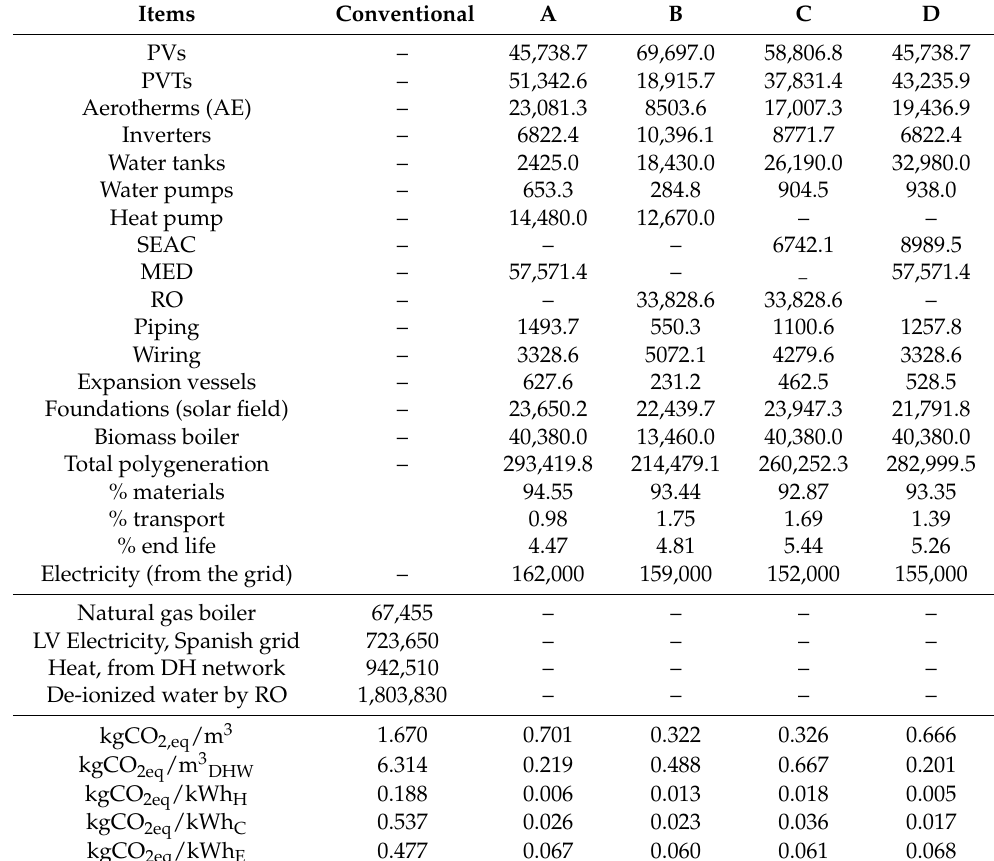
Table 11. Total emissions (in kgCO 2eq ) of the polygeneration scheme.